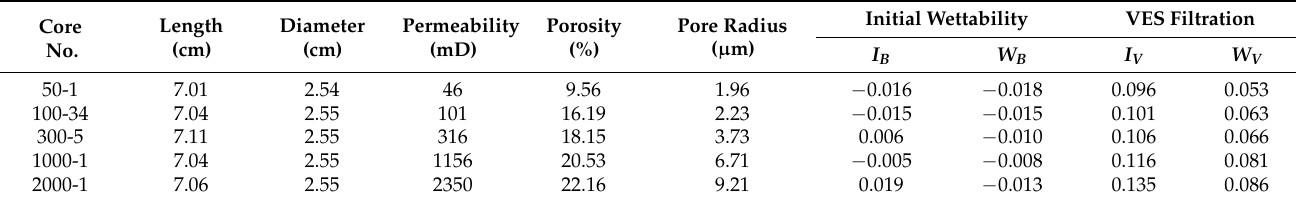
Table 6. Effect of pore radius on wettability.